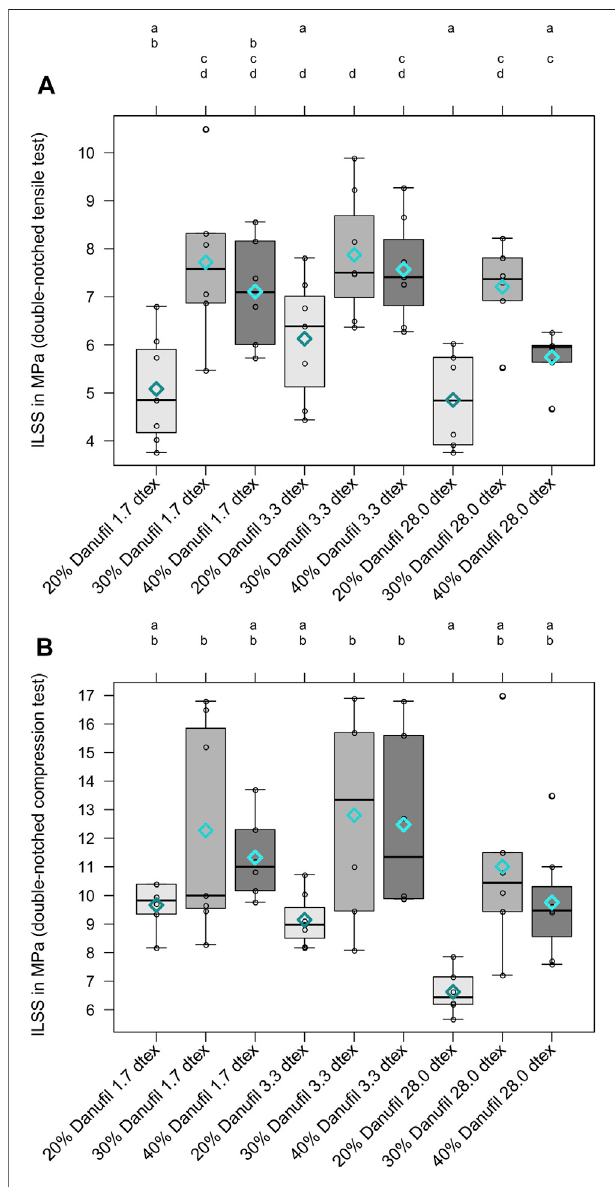
FIGURE12 | Interlaminar shear strength (ILSS) determined by adouble- notched tensile test (A) and ILSS determined by a double-notched compressiontest (B) .ResultsareshownasBox-Whisker-Plotswiththemean values as rhombuses. Different letters indicate signi fi cant